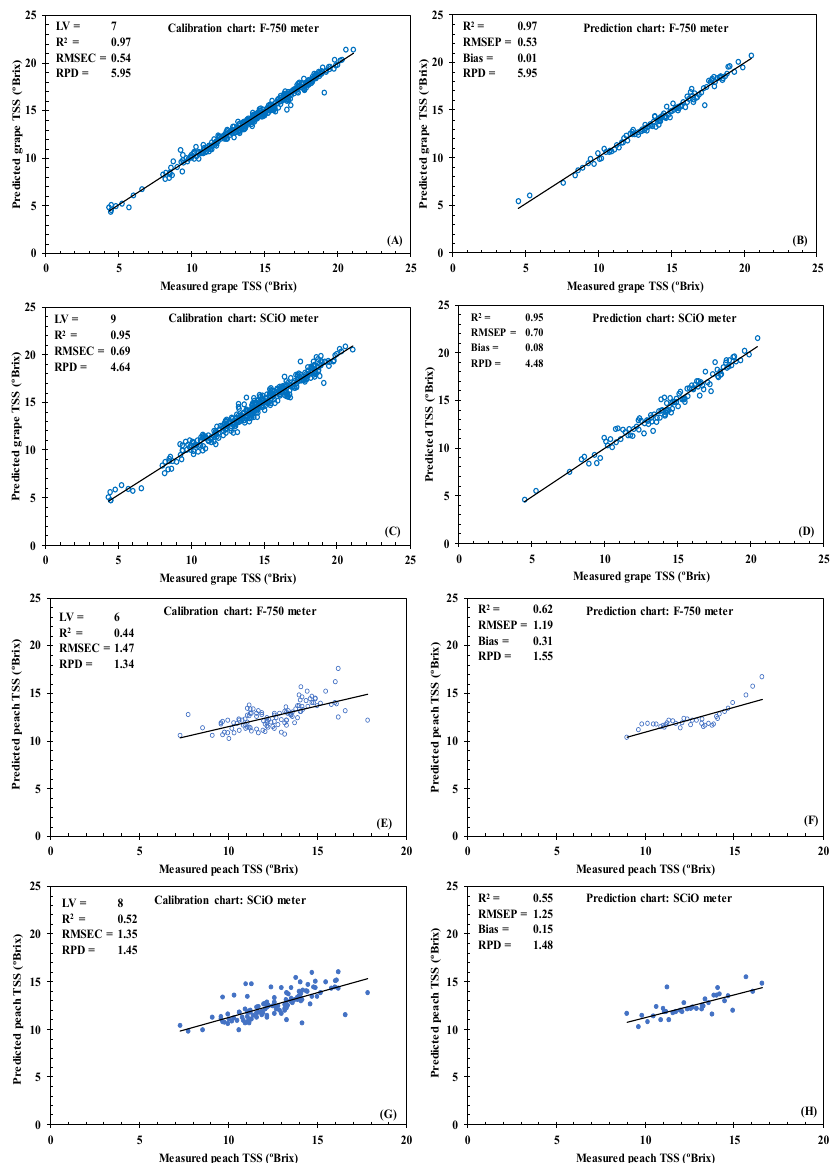
Figure 5. Scatter plot of measured versus predicted total soluble solids (TSS) values of table grapes ( A – D ) and peach ( E – H ) calculated using the best PLSR calibration model for the F-750 and SCiO spectrometers. The black line represents the linear correlation between the measured values obtained from the reference quality attribute and their prediction by the model.